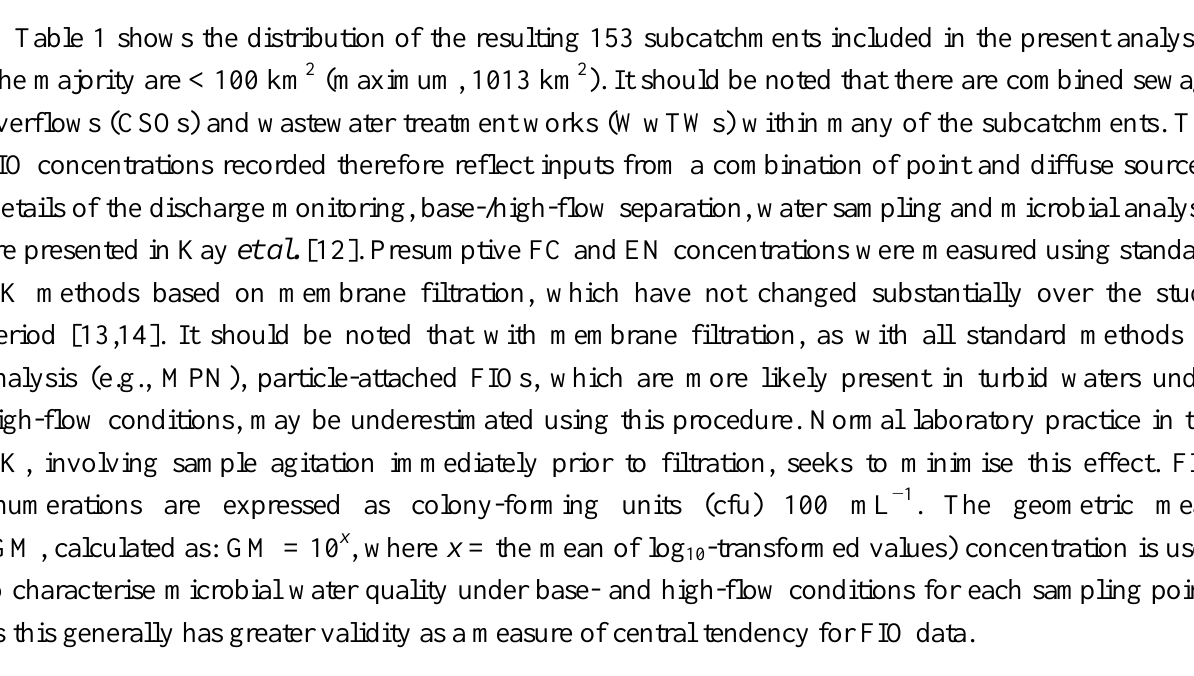
Table 1. Catchments reported in present